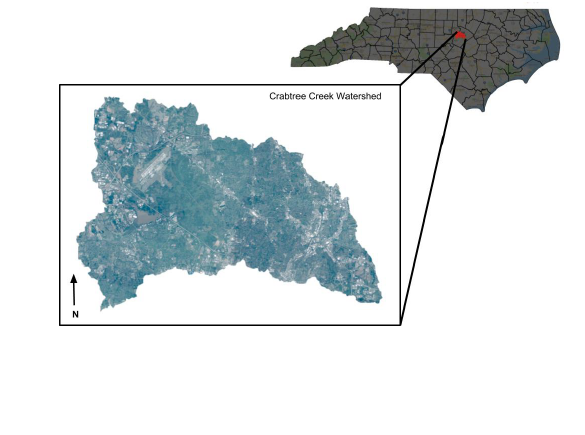
Figure 1: Crabtree Creek Watershed (376.25 km2) in the Re- search Triangle, North Carolina,